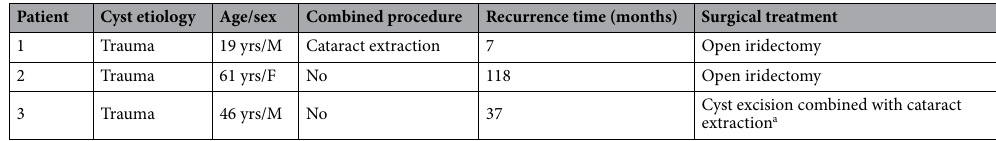
Table 2. Details of the recurrence and management. *yrs, years; M, male; F, female; a, the surgery was performed at another hospital.